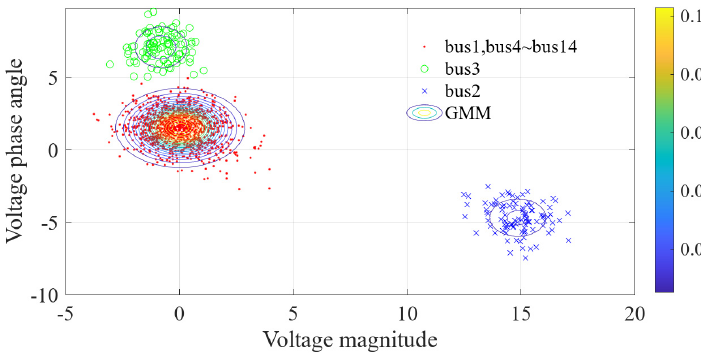
Figure 22. Classification results of the EM algorithm.